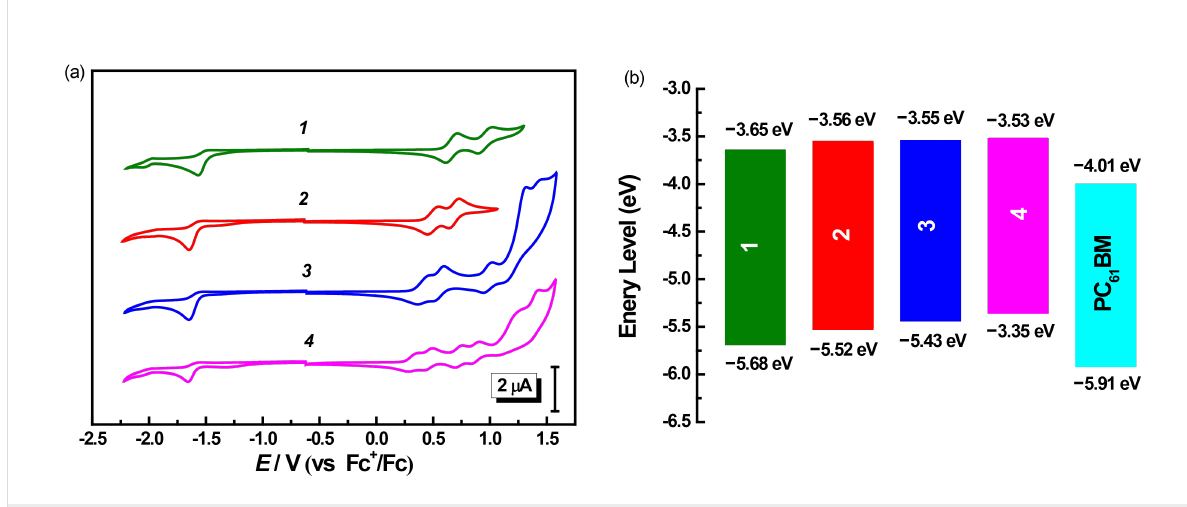
Figure 2: (a) Cyclic voltammograms of 1 – 4 measured in CH 2 Cl 2 solution (1.0 × 10 − 3 mol·L − 1 ) with 0.1 mol·L − 1 Bu 4 NPF 6 at a scan rate of 100 mV·s − 1 ; (b) HOMO and LUMO energy levels of these compounds.